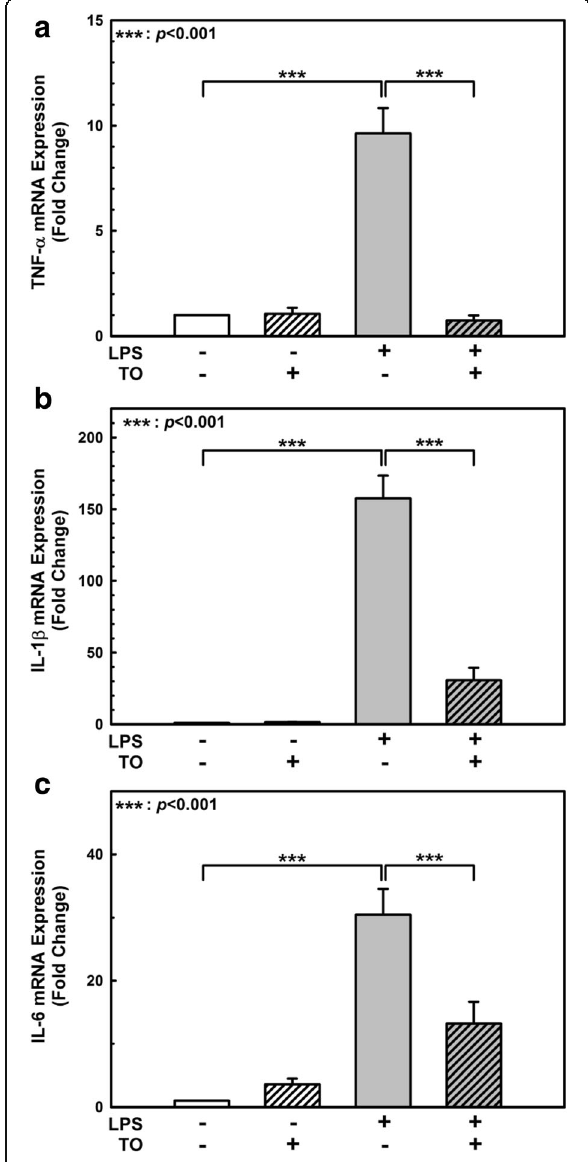
Fig. 4 Effect of the Taraxacum officinale (TO) methanol extract on LPS-induced pro-inflammatory cytokine expression. The pro-inflammatory cytokine mRNA levels were normalized to that of a housekeeping gene (18S rRNA) as well as the vehicle-only-treated control, and the 2 - ΔΔ Ct for each mRNA is reported. Results shown are the mean ± SE of 3 independent experiments ( a , b , c ). *** p < 0.001 vs LPS only